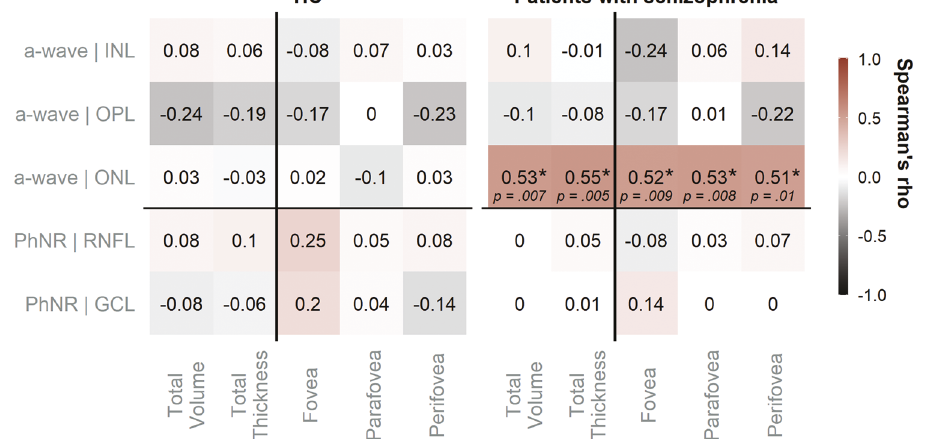
Fig. 4 Exploratory correlation analysis. Spearman ’ s rho (depicted) computed for correlation analyses comparing ERG amplitudes and thicknesses of the corresponding layers of origin. Signi fi cant correlations (uncorrected) are marked by “ * ” . HC healthy controls, GCL ganglion cell layer, INL inner nuclear layer, IPL inner plexifom layer, ONL outer nuclear layer, OPL outer plexiform layer, RNFL retinal nerve fi ber layer, * signi fi cant.